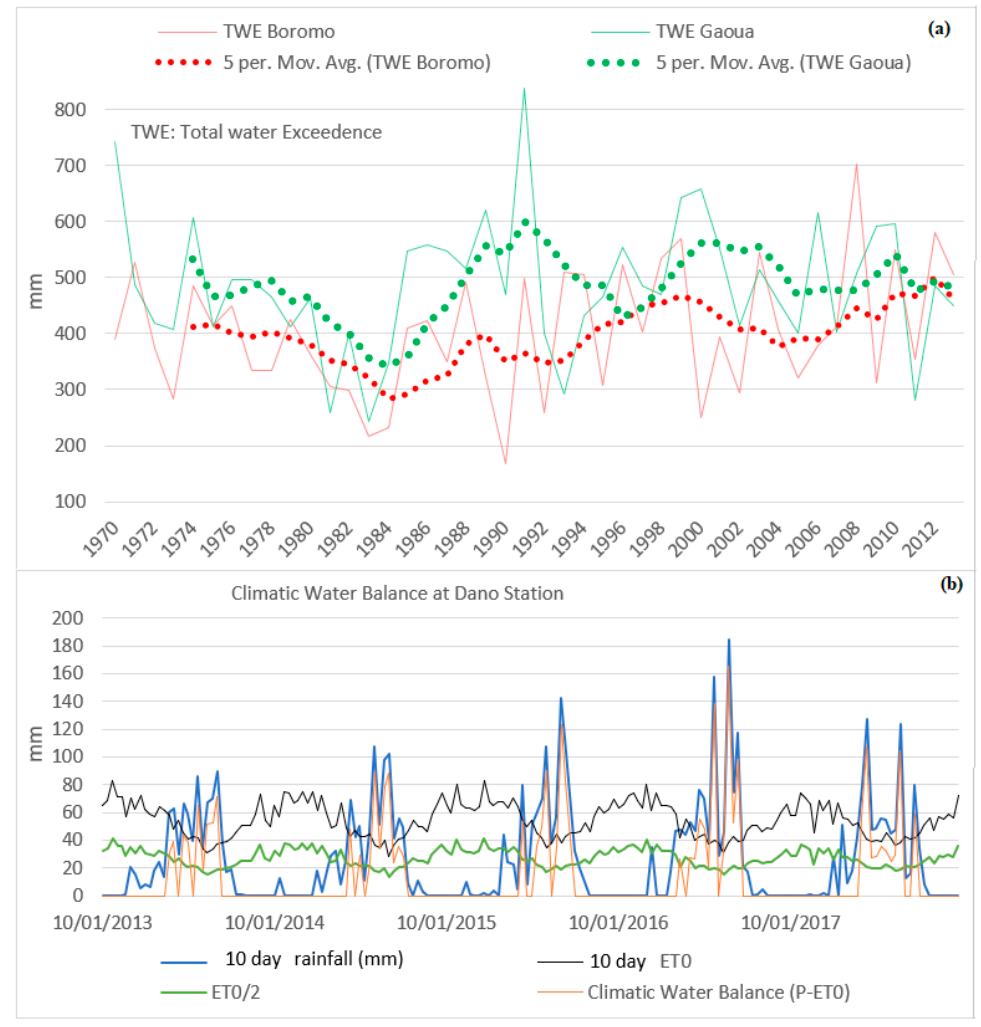
Figure 5. Water excess at Boromo and Gaoua rainfall stations from 1970 to 2012 ( a ) and the climatic water balance at Dano station (2013:2017) ( b ).